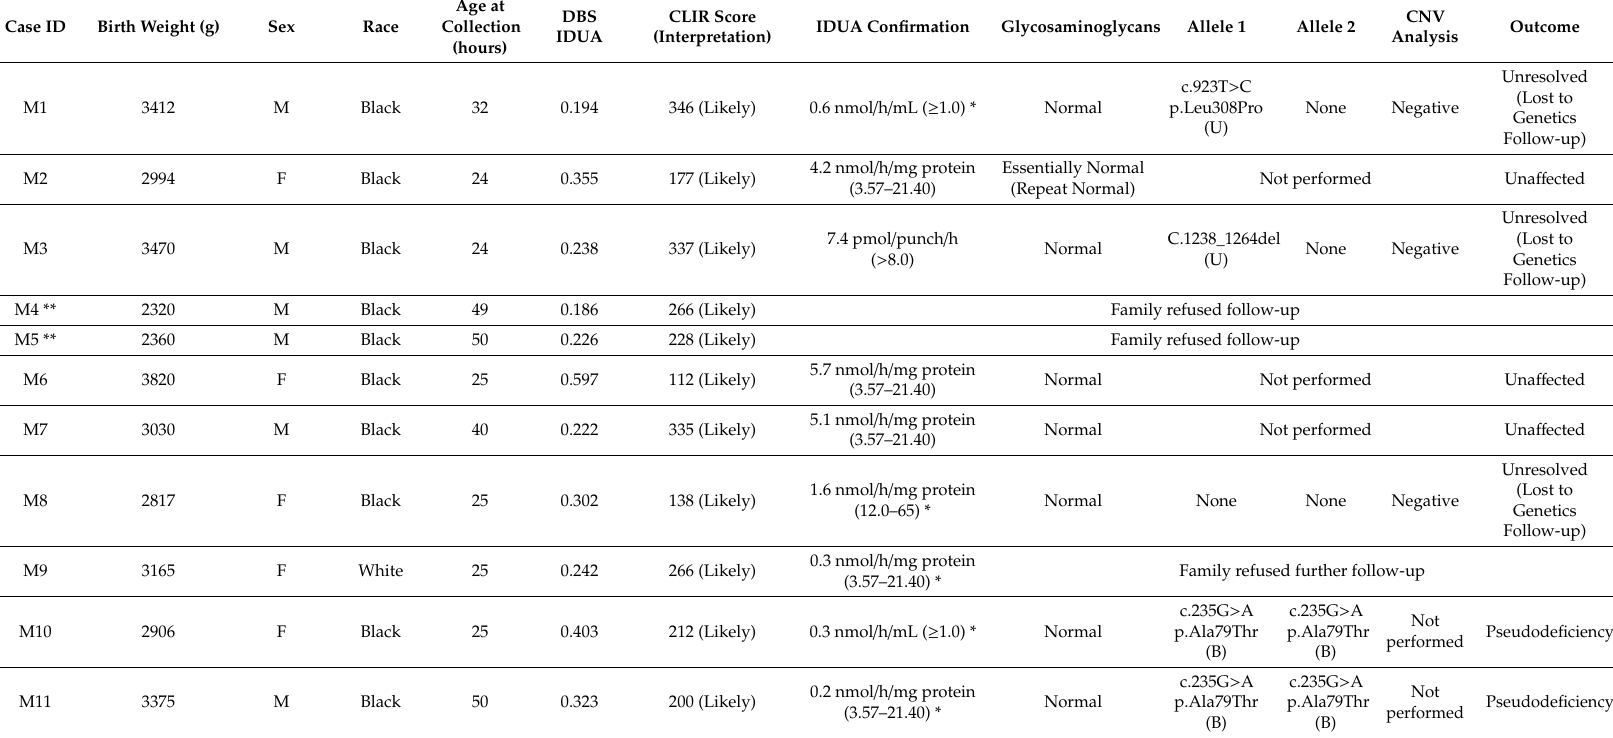
Table 3. Positive screens for MPS I during Georgia pilot study. CLIR interpretation possibilities are uninformative (below 1st percentile), possible (1st–5th percentiles), likely (5th–20th percentiles) and very likely ( > 20th percentile). Variant interpretations are those received from the clinical laboratory performing testing (B = benign; U = variant of uncertain significance). * Enzyme results interpreted by testing laboratory as abnormal; laboratory specific reference ranges are shown in parentheses. ** Cases 4 and 5 are twin